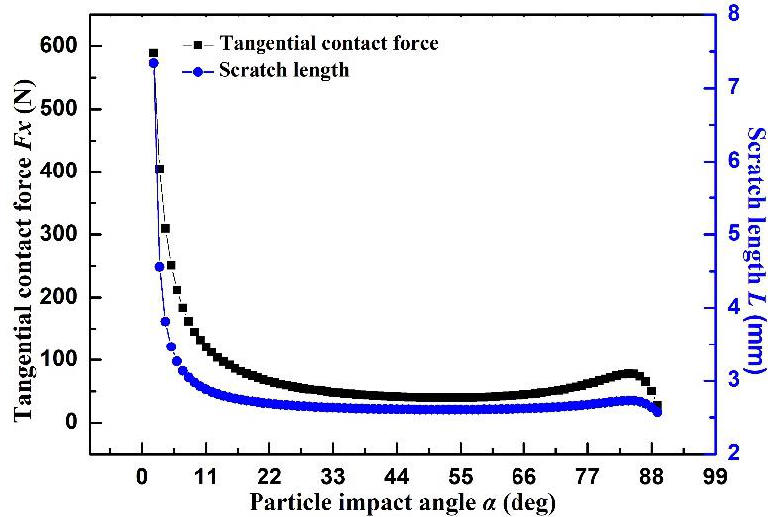
Figure 8. Tangential contact force and scratch length versus different impact angles.